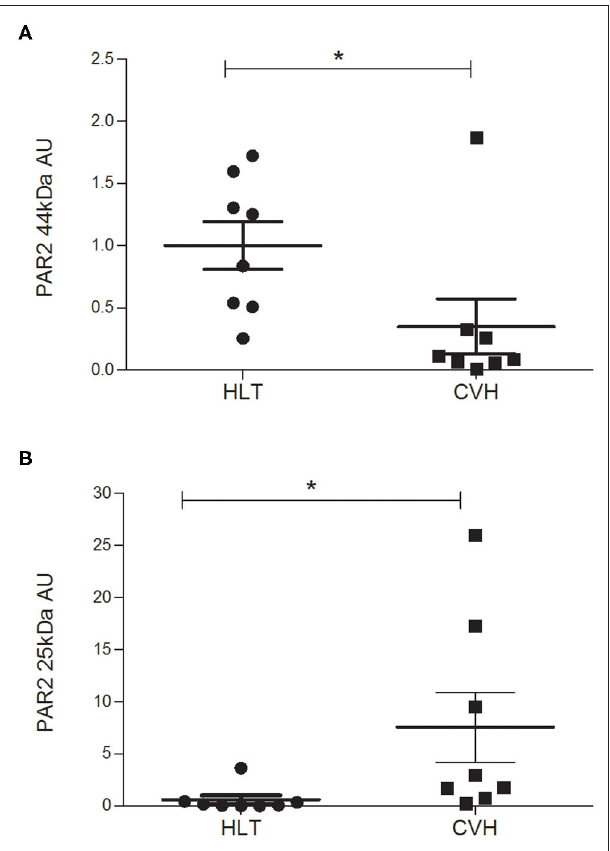
FIGURE 5 | Protein expression level of the PAR 2 in horses during colon volvulus (CVH group, n = 8) and in colon of healthy horses (HLT group, n = 8). The densitometric analyses were carried out on the expected molecular weight for the PAR 2 ( ∼ 44 kDa, A ) as well as on the smaller band ( ∼ 25 kDa, B ). The *indicates the statistically significant differences between the HLT and the CVH groups (student t -test, p < 0.05). AUs: arbitrary units in relation to reference protein ( α